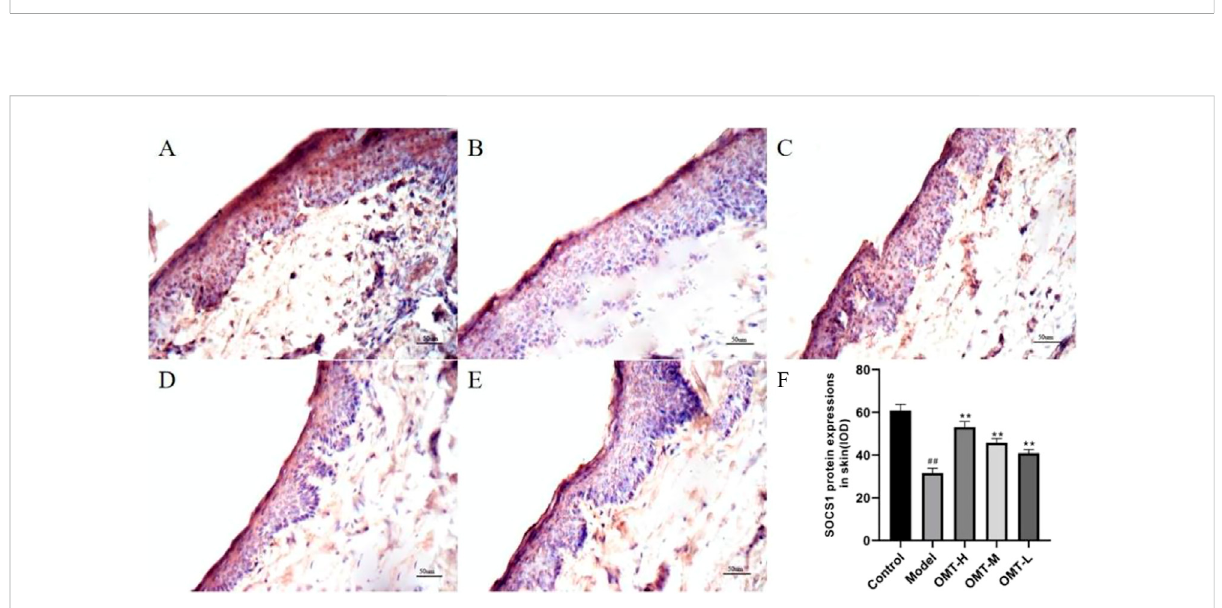
Positive expression of SOCS1 in skin tissue (immunohistochemical staining, × 200). (A) Normal control group; (B) Model group. (C) OMT-H group. (D) OMT-Mgroup. (E) OMT-Lgroup. (F) StatisticaldataofpositiveexpressionofSOCS1ineachgroup.( ## , p < .01,vs.Controlgroup;**, p < .01, vs. model